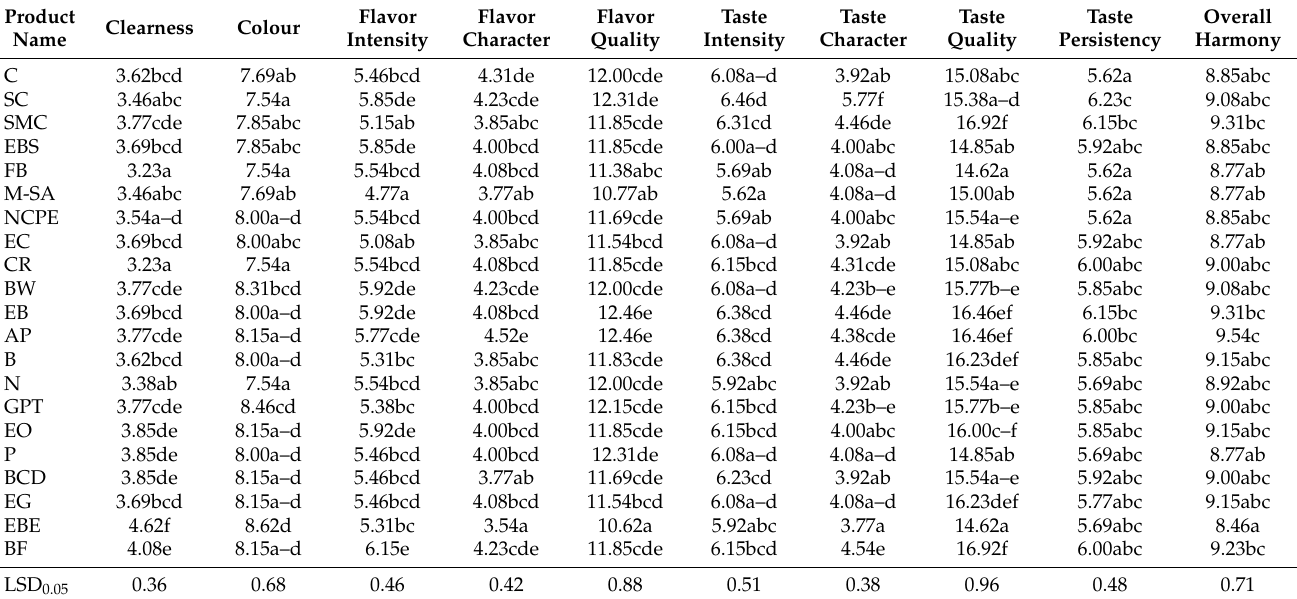
Table 7. Effect of twenty-one bentonite product treatments including controls on ten organoleptic parameters in white wine samples (Debrecen-Pallag, Hungary). Different letters within each col- umn are significantly different among the bentonite product treatments at p = 0.05 according to LSD t-tests (LSD 0.05 ). Explanations for bentonite product name abbreviations are given in Table 1. Scales for the 10 parameters including the two anchors were as follows: skin and flesh colour: 0 = unacceptable, 9 = excellent; flavour intensity and character: 0 = very weak, 8 = very strong; flavour quality: 0 = unacceptable and 15 = excellent; taste intensity, character and persistency: 0 = very